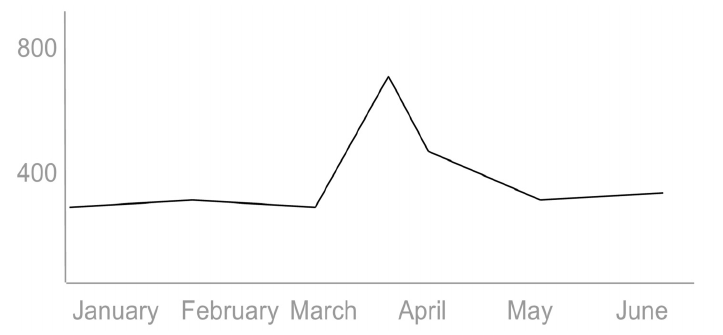
Figure 4. Spike in costs during the high volume of interlinking